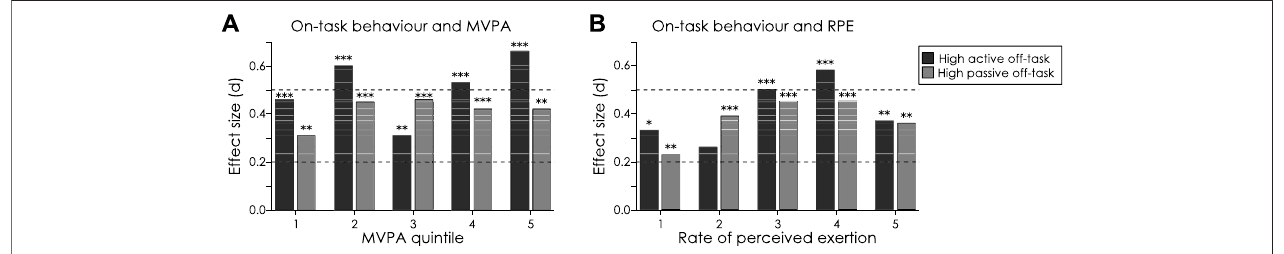
FIGURE 5 | Change in behaviour in response to objective and subjective measures of physical activity intensity in the most off-task participants. (A) On-task behaviour and MVPA (B) On-task behaviour and RPE. Note. MVPA (cid:1) Moderate-to-vigorous physical activity. Effect sizes have been transformed so that positive numbersre fl ectfavourableeffects(moreon-taskbehaviour,lessoff-taskbehaviour).Small(d (cid:1) 0.2),medium(d (cid:1) 0.5),andlarge(d (cid:1) 0.8)effectsizesareindicatedbythe dashed grid lines. * p ≤ 0.05, ** p ≤ 0.01, and *** p ≤ 0.001.